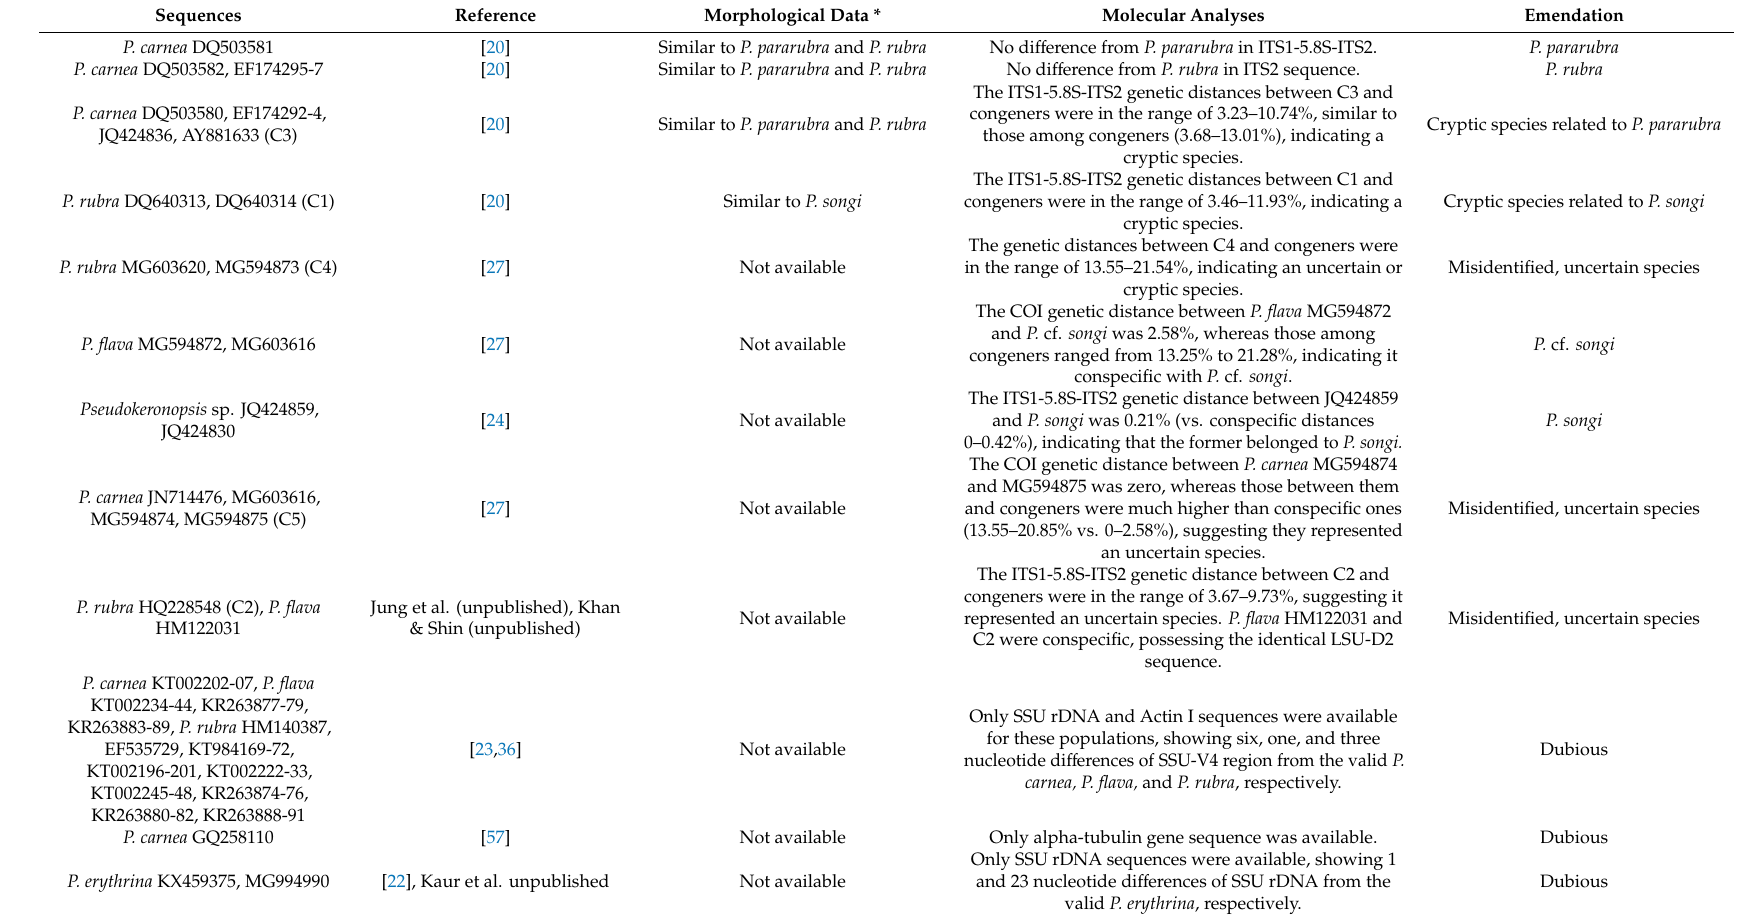
Table 2. Emendation for the misidentified or uncertain Pseudokeronopsis sequences in